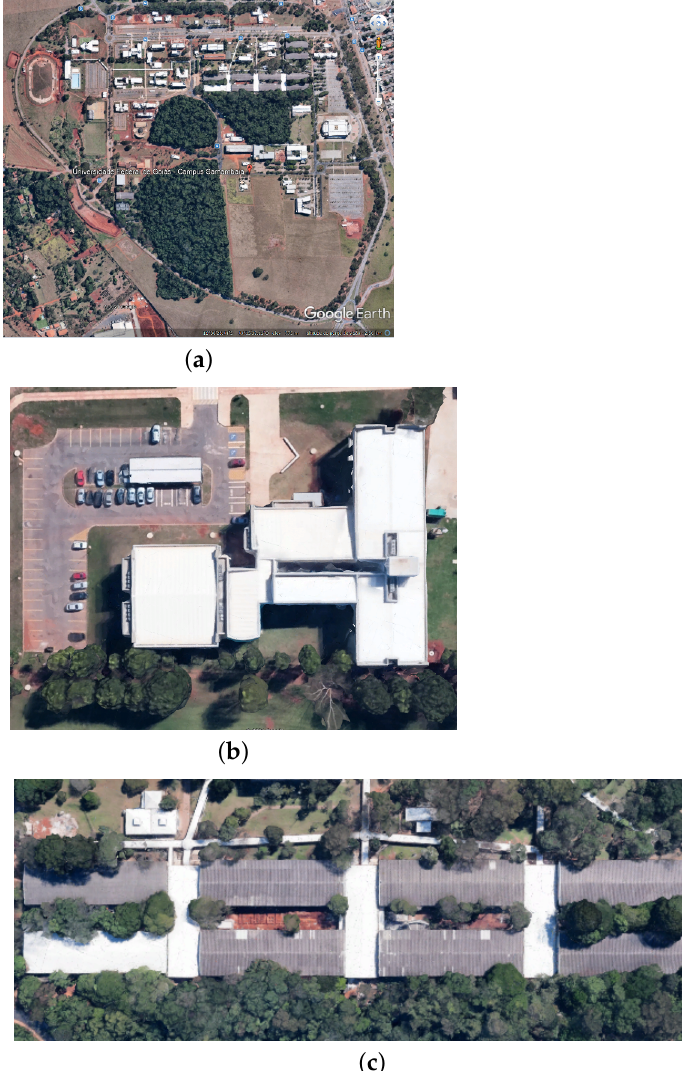
Figure 4. The Samambaia Campus and departments of UFG: ( a ) the Samambaia Campus; ( b ) the Institute of Informatics; ( c ) the academic